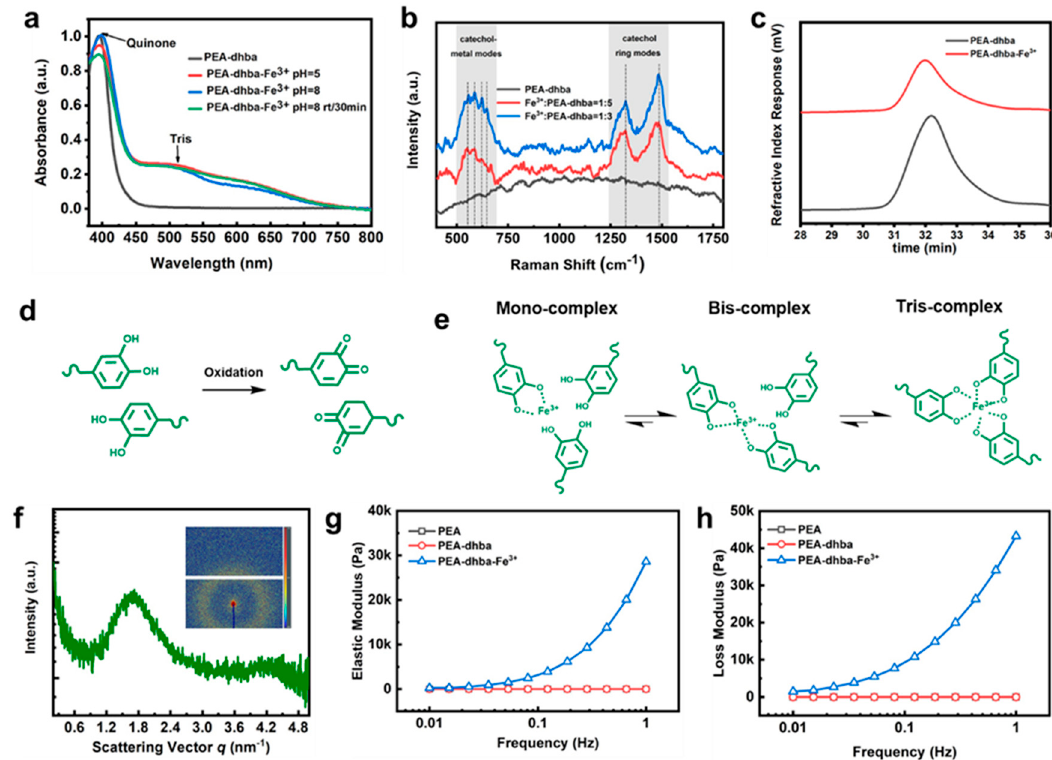
Figure 2. ( a ) UV-vis absorbance of diluted PEA-dhba and PEA-dhba-Fe 3+ solutions; ( b ) Raman spectroscopy of neat PEA-dhba and complexes with 1:3 and 1:5 molar ratio; ( c ) GPC information of as-synthesized PEA-dhba and sample open to air for 6 h; ( d ) oxidation of catechols into quinone form; ( e ) complexation modes of catechol-Fe 3+ in PEA-dhba-Fe 3+ ; ( f ) SAXS results of dried PEA-dhba-Fe 3+ bulk, and the inset shows its two-dimensional (2D) pattern; ( g ) elastic modulus; and ( h ) loss modulus obtained from frequency-sweeping rheological measurements for dried PEA, PEA-dhba, and PEA-dhba-Fe 3+ .